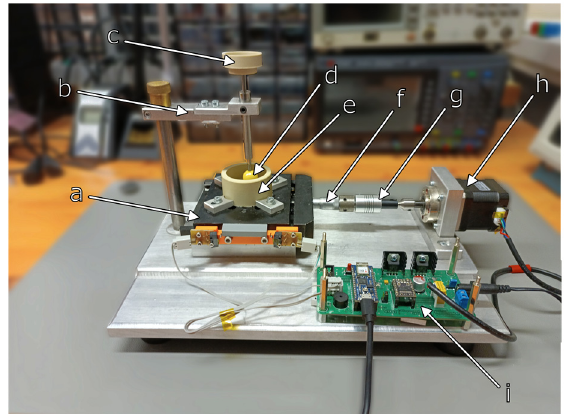
Figure 1. Wear machine: a—sliding table, b—indenter crane, c—indentation mass holder, d— indenter effector (zirconium ball), e—sample fluid cell, f—micrometer screw, g—clutch, h—stepper motor, and i—stepper motor driver.